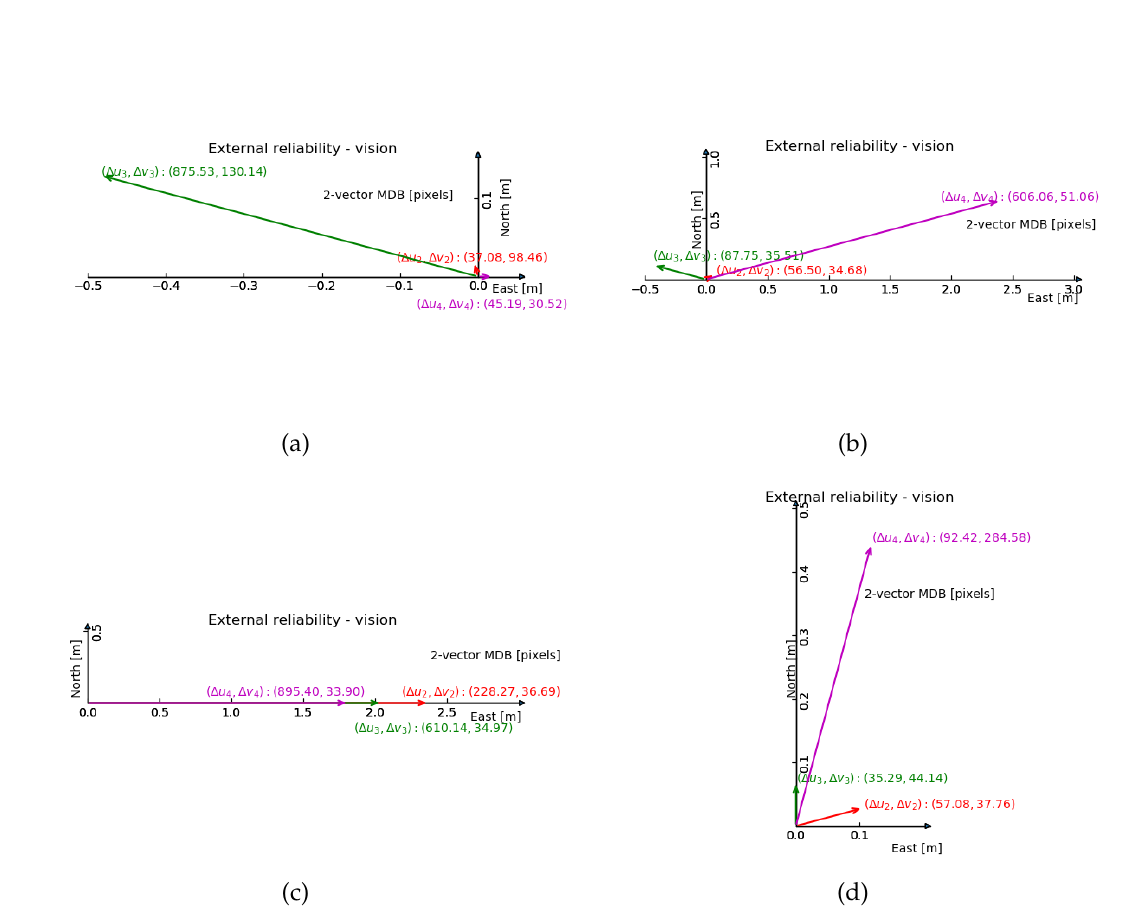
Figure 8. 2-fault external reliability computed by 3 features in 4 geometries in [m], the bias vector with largest magnitude is shown (in terms of horizontal position), and the corresponding internal reliability values are given between brackets. ( a ) Normal geometry; ( b ) Cluster; ( c ) Line up in x direction; ( d ) Line up in y